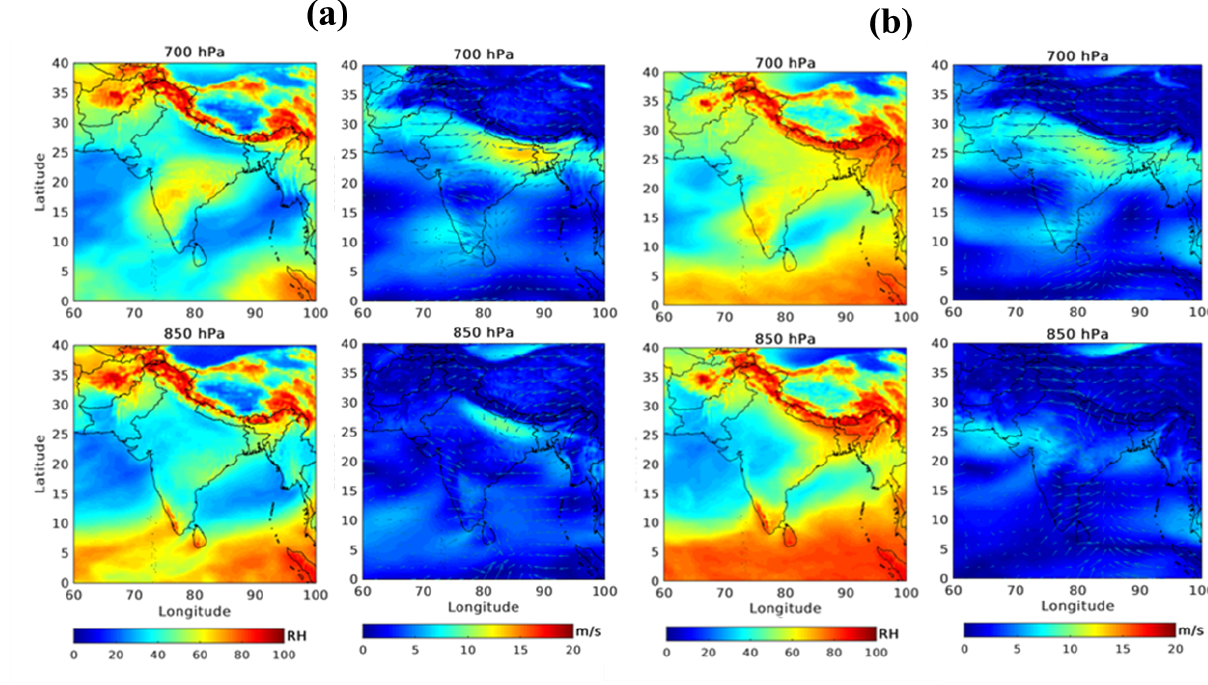
Figure 7. Mean relative humidity (%) and mean winds (ms − 1 ) observed at 700 and 850hPa (a) phase I of lockdown and (b) phase II of